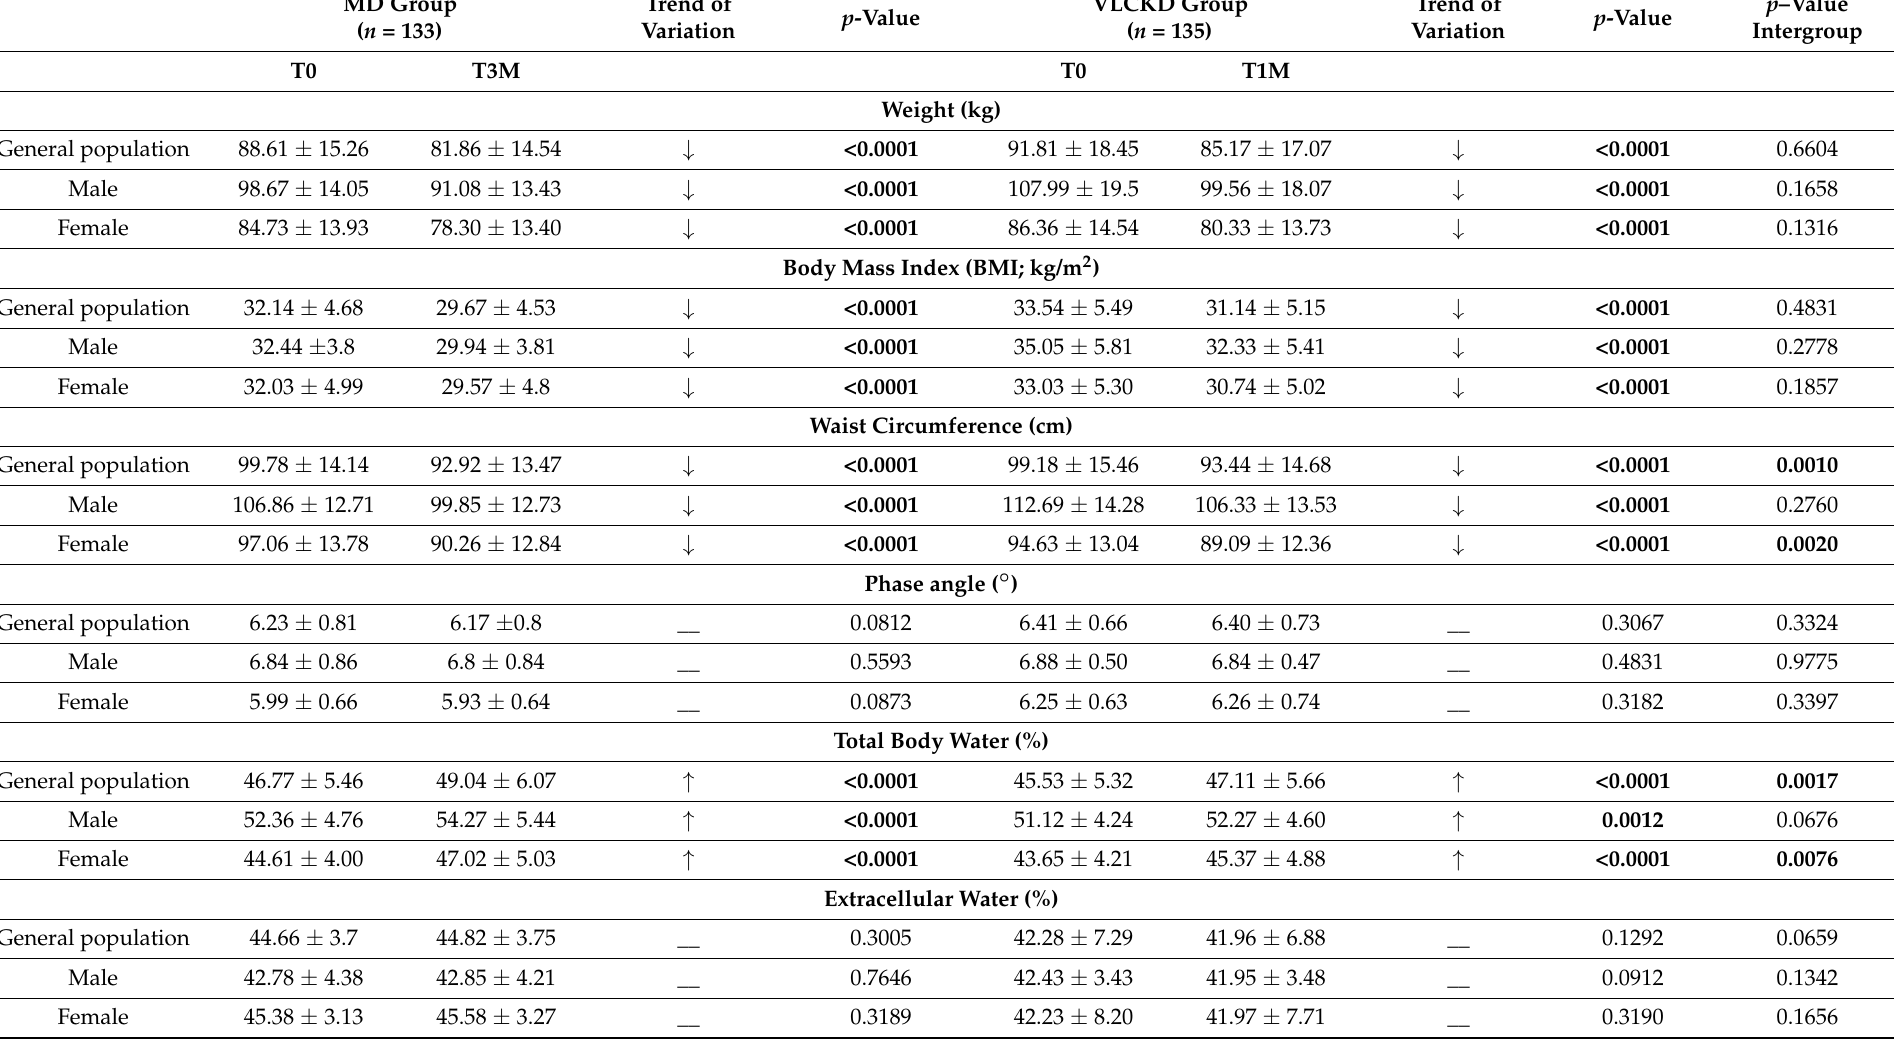
Table 1. Anthropometric and Body composition changes in MD and VLCKD groups (mean ±